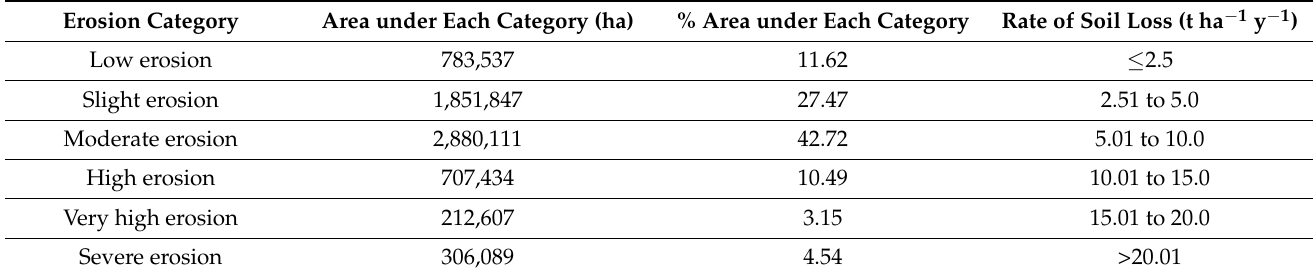
Table 3. Quantification of average annual soil loss at northern dry zone of Karnataka (1951 to 2020). Erosion Category Area under Each Category